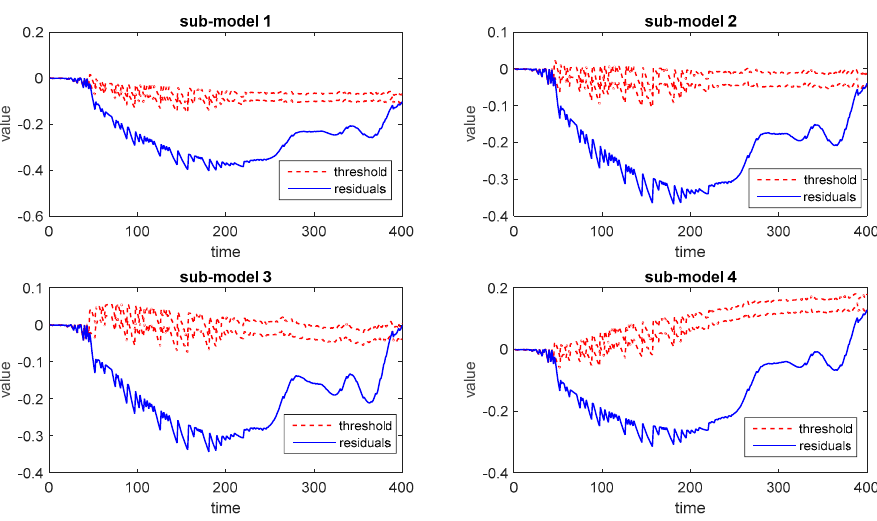
Figure 12. Monitoring results of fault 3 in penicillin fermentation case.